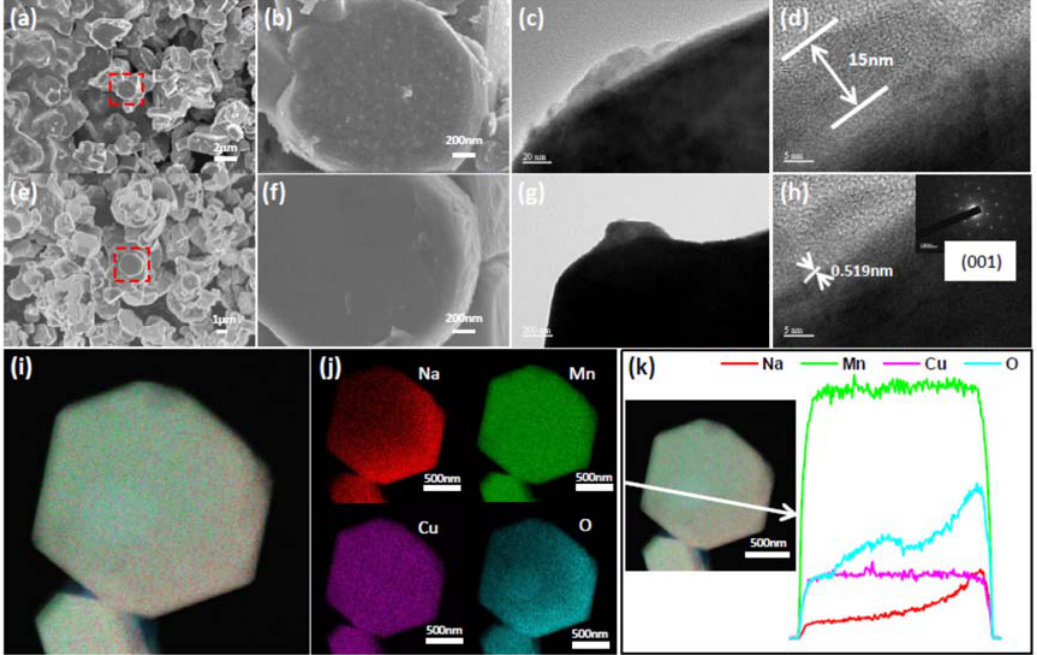
Figure 2. A series of characterization tests before and after treatment of NMO. ( a , b ) SEM results of NMO before and after treatment; ( e , f ) SEM results of treated NMO; ( c , d , g , h ) TEM results of treated NMO; ( i , j ) high-surface sweep mapping of treated NMO; ( k ) line scan data of treated NMO.